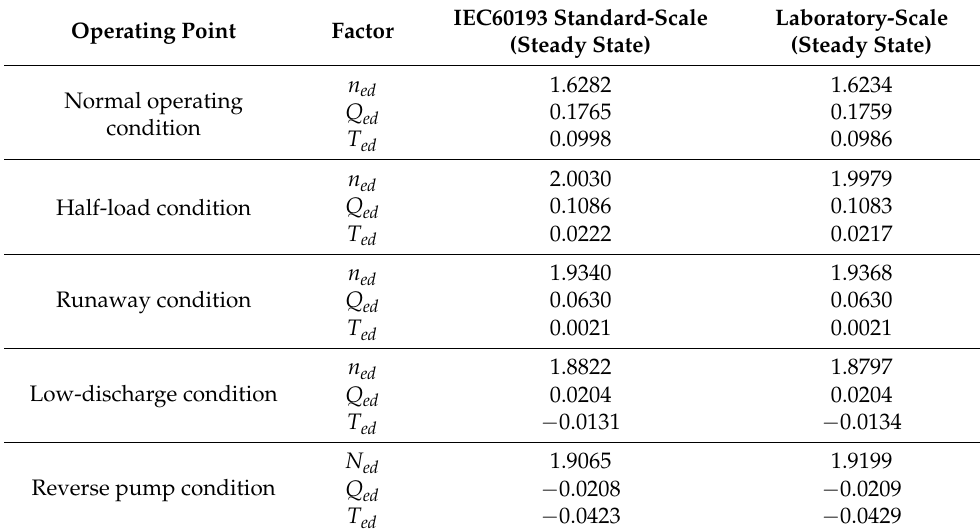
Table 6. Comparison of the S-shaped characteristics of model scales at 21.5 ◦ GVO.